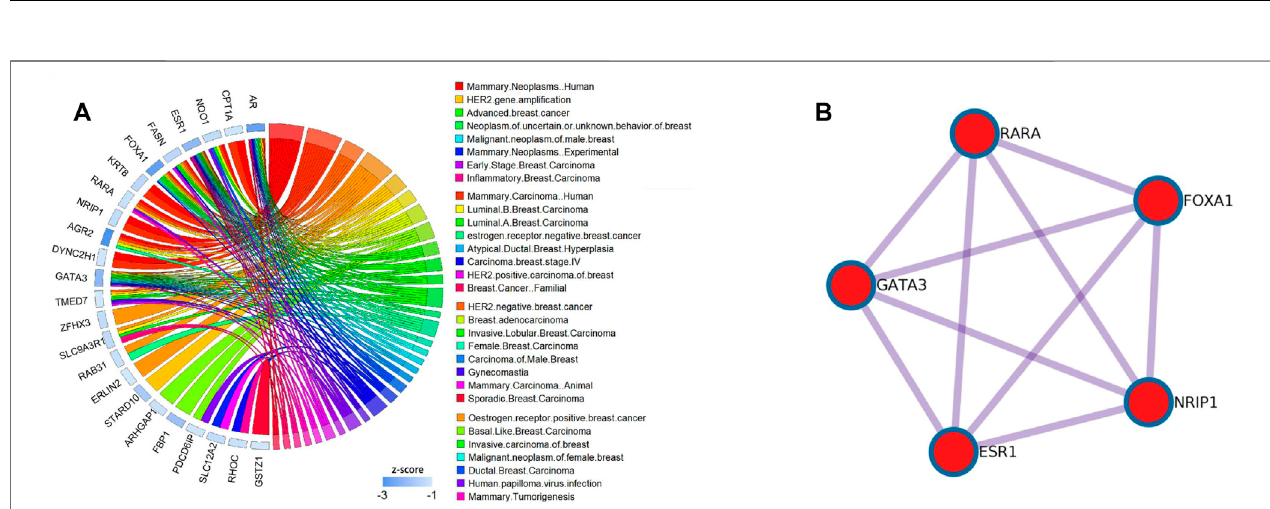
FIGURE 4 | Pathway numbers with screened genes of GO, KEGG, and Reactome in the bio-enrichment analysis; (A) number of pathways in the BCI data set; (B) numberofpathwaysintheBCIIdataset; (C) numberofpathwaysintheGCdataset.ThebluebaristheDM-ESPCAmodel,theorangebaristheESPCAmodel,andthe gray one is the SPCA model.